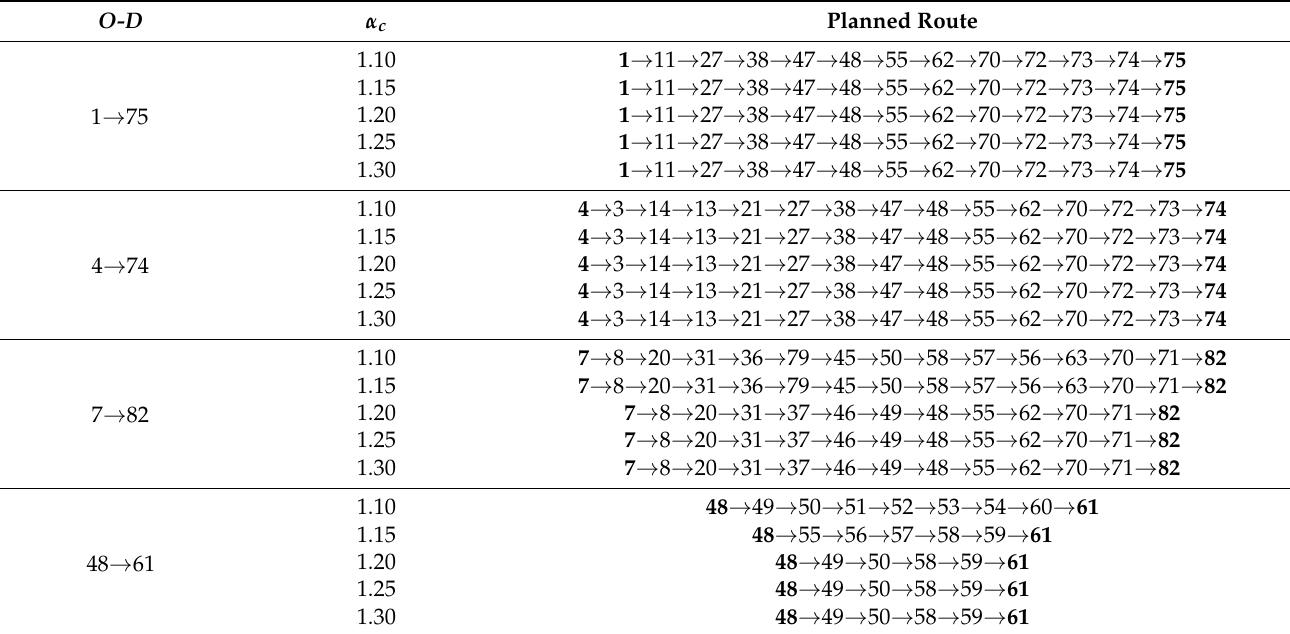
Table 8. Planned routes in different situations.